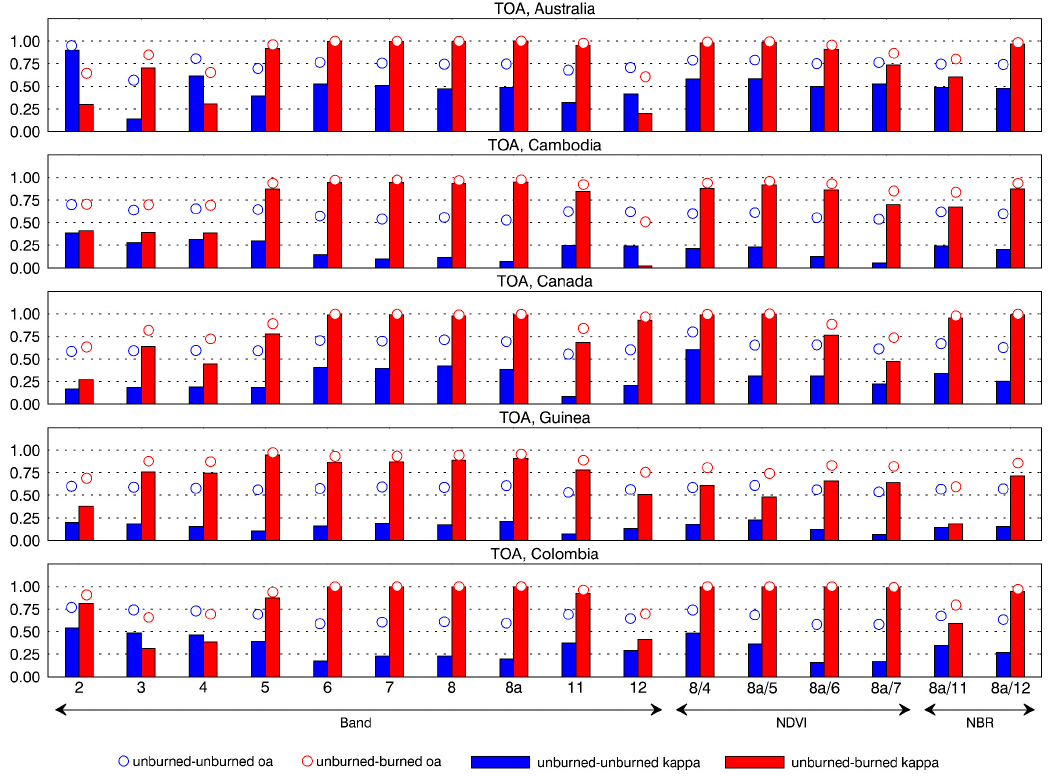
Figure 6. Decision tree top of atmosphere (TOA) separability values for the ten MSI bands (Table 2) and the six spectral indices (Table 3). Overall accuracy values are shown as circles and Kappa values are shown as bars.